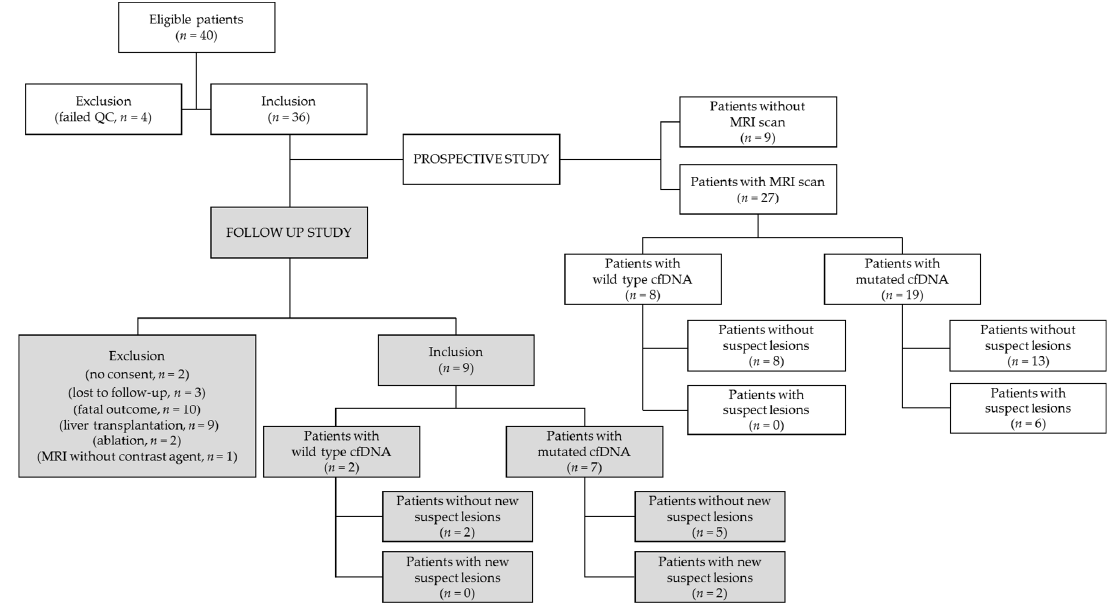
Figure 1. Flow chart showing the distribution of LC patients with respect to patients’ inclusion/exclusion, cfDNA analysis and imaging results in the primary prospective (white rectangles) and in the follow-up (grey rectangles) studies. Table 4. Distribution of variants among the patients who received an MRI. Twenty-seven